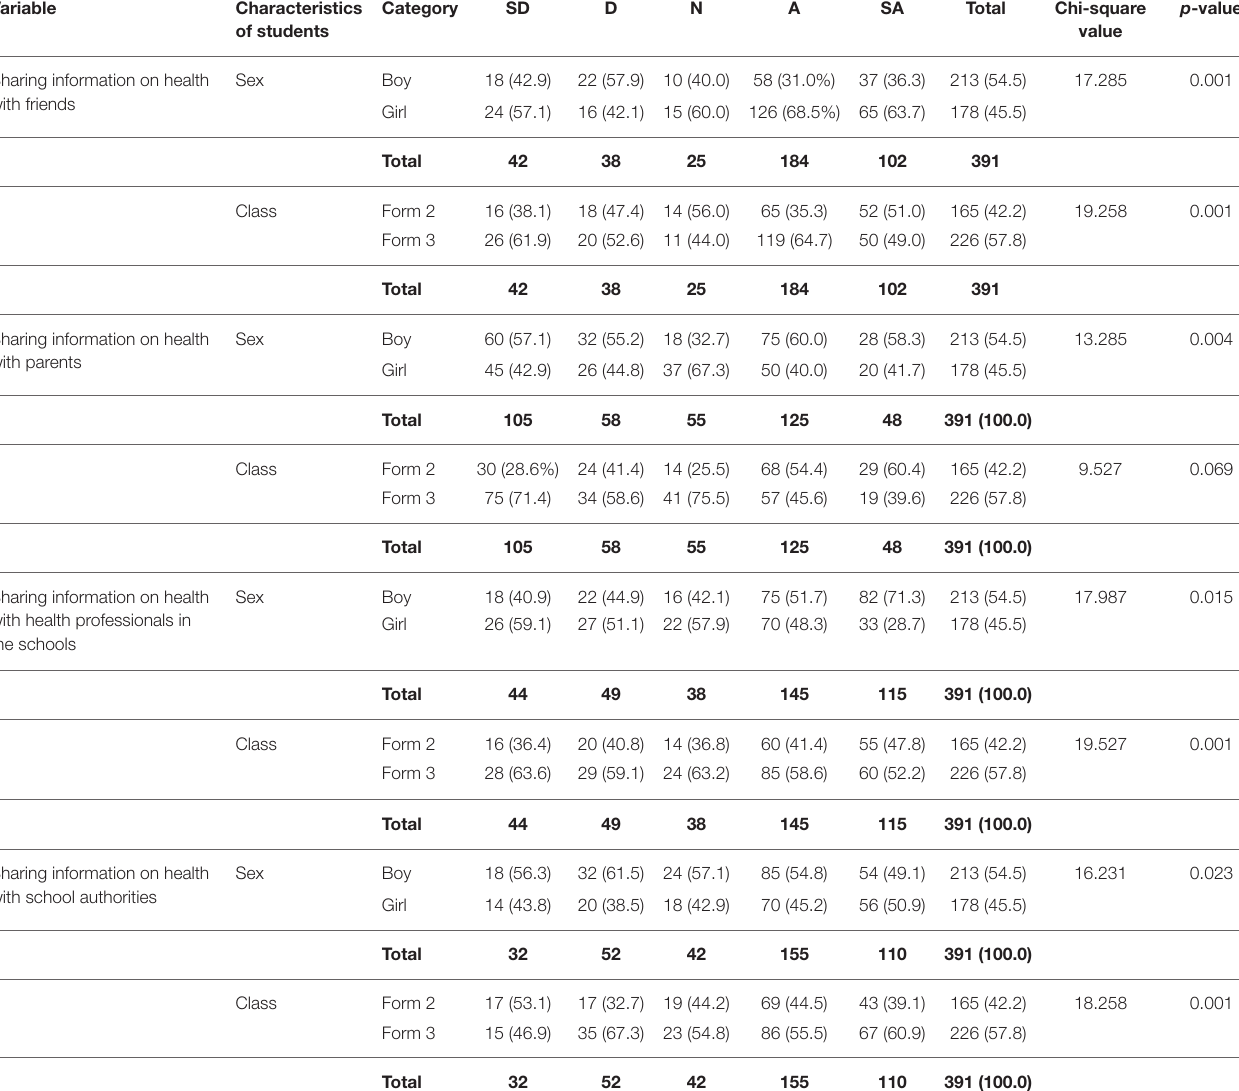
TABLE 7 | Attitudes toward sharing health information by students.